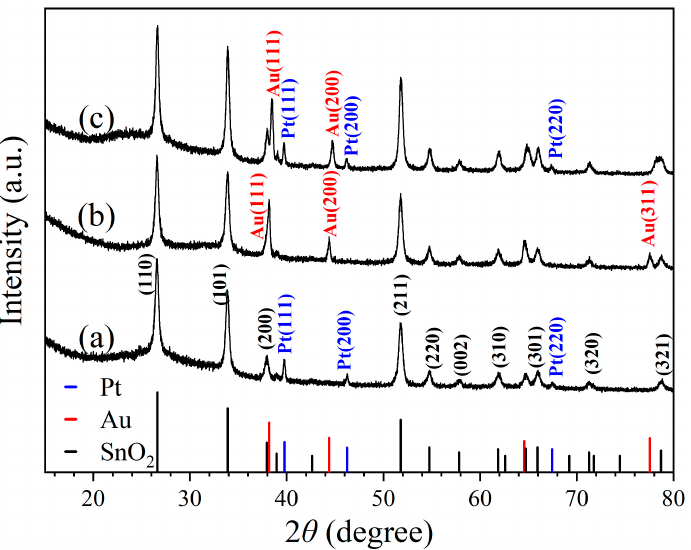
Figure 1. X-ray diffraction patterns taken for samples of ( a ) 1 wt% Pt–SnO 2 , ( b ) 5 wt% Au–SnO 2 , and ( c ) 1 wt% Pt–5 wt% Au–SnO 2 , after being sintered at 950 °C for 2 h in the air.